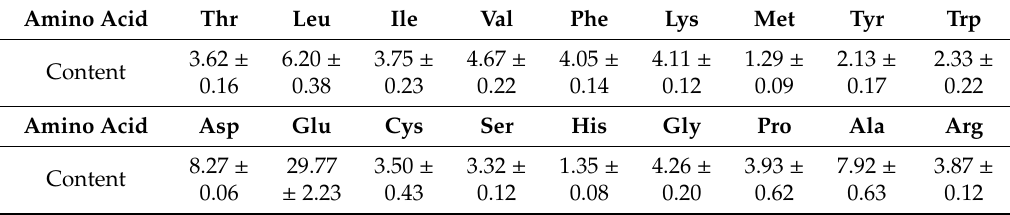
Table 1. Amino acid content of S. maclurei protein (g / 100 g